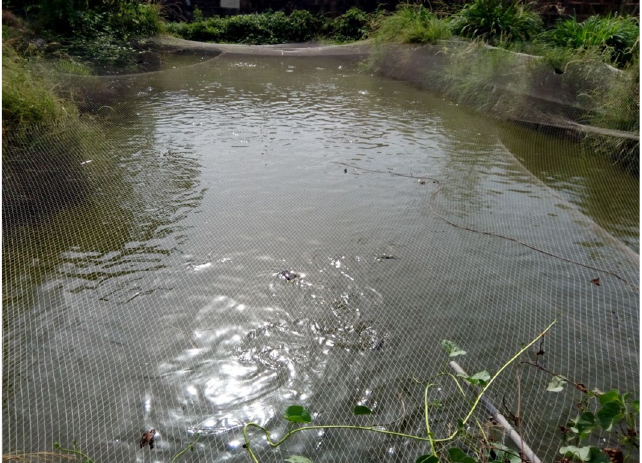
Figure 2. The collection point for AQEF (Latitude: 6 o 14 ′ 32.13 ″ N, Longitude: 7 o 06 ′ 16.44 ″ E). [This Figure was taken by "Chinenye Adaobi Igwegbe" during the research at point of wastewater